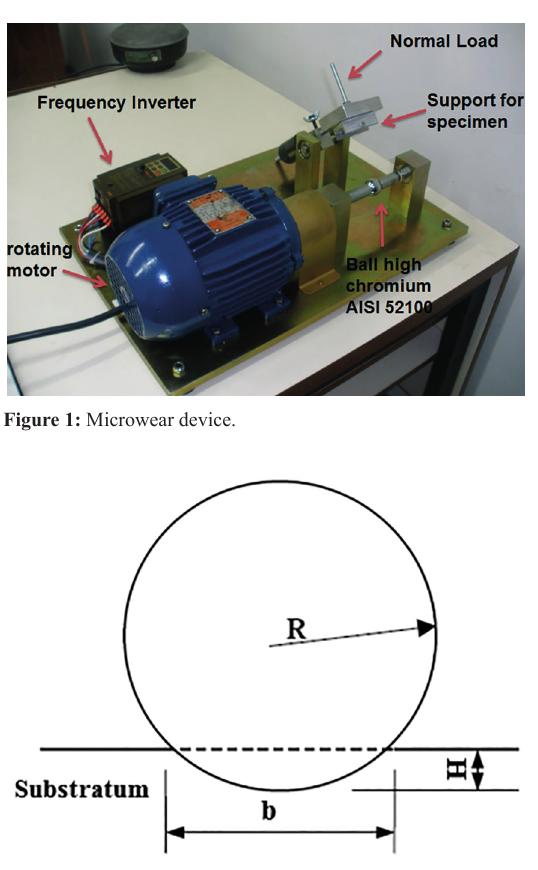
Figure 2: Circular depression geometry (wear scar) produced in microwear test.